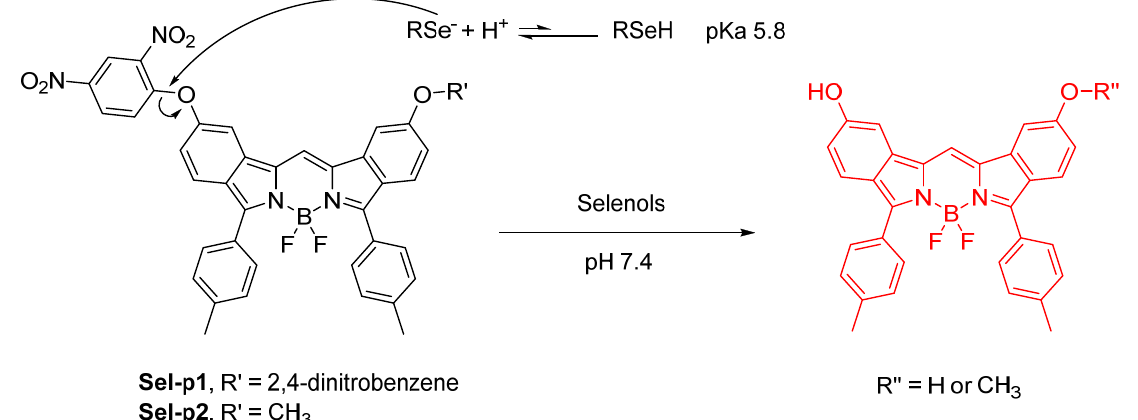
Figure 54. Detection mechanism of Sel–p1 and Sel–p2 by Dai et al. towards selenols.